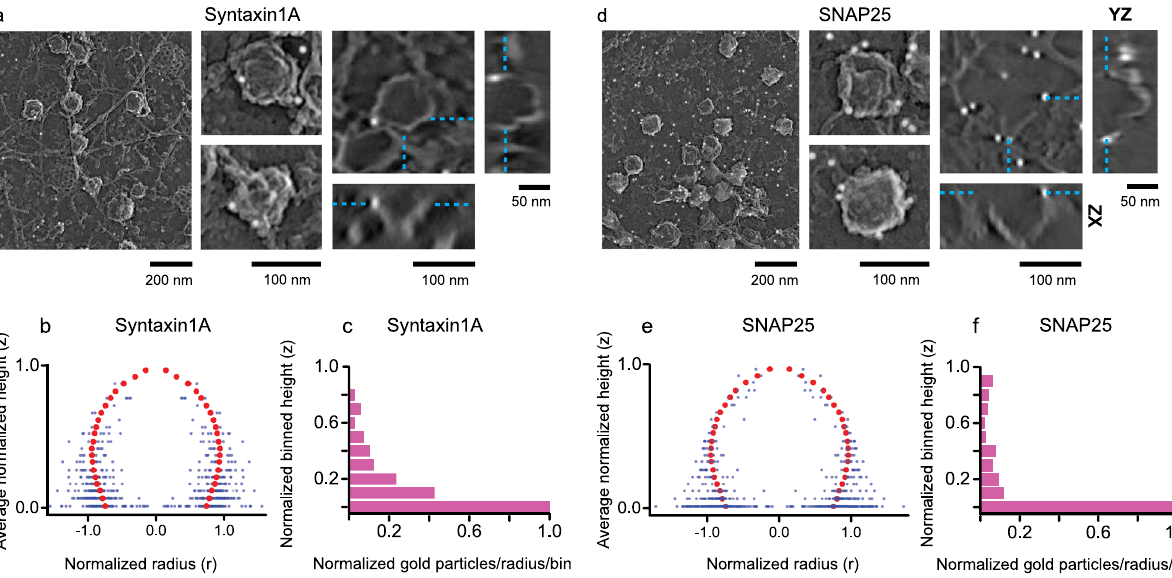
Fig. 6 2D and 3D visualization of Syntaxin1A and SNAP25 on DCVs. 2D PREM images of PC12 cells transfected with His-tagged a Syntaxin1A and d SNAP25. The left panel (scale bar is 200 nm) shows a representative crop from a larger PREM image (Supplementary Fig. 12), the middle panel (scale bar = 100 nm) shows enlarged examples of individual DCV structures labeled with Ni-NTA-Au, and the right panel shows tomogram slice ( XY view, scale bar = 100 nm) of an individual DCV structure labeled with Ni-NTA-Au and the XZ (scale bar = 100 nm) and YZ (scale bar = 50 nm) views for the z slice denoted by cyan dashed lines. b , e Spatially averaged and normalized distribution pro fi les for Syntaxin1A and SNAP25. The gold particles are re fl ected across the ordinate. c , f Density of gold-labeled proteins along the vesicle height (10 bins). The histograms show the sum of particles in each bin (for all vesicles) divided by the average radius of the bin per vesicle. The total number of vesicles collected and analyzed from two independent experiments (for a – f ) are Syntaxin1A: 76, and SNAP25: 65 (Supplementary Table